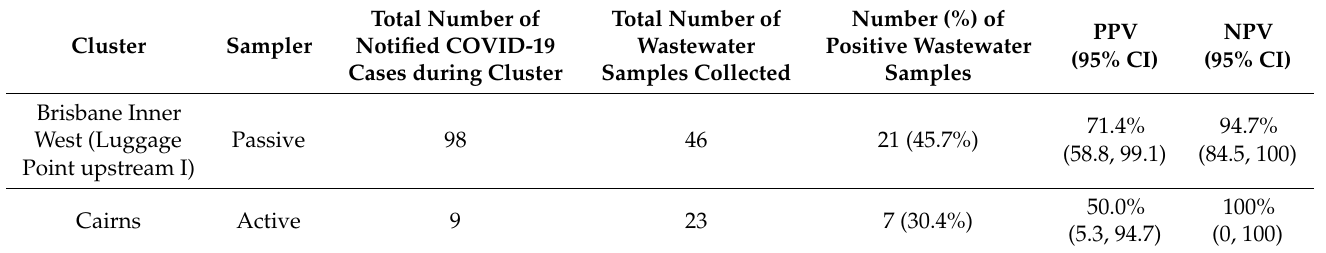
Table 1. Positive predictive value (PPV) and negative predictive value (NPV) of wastewater detections for the presence or absence of notified COVID-19 cases per catchment cluster in Luggage